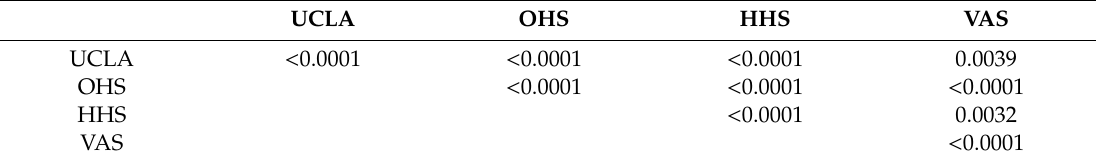
Table 4. Probability ( p ) value for the correlation of each combination of clinical measurements.